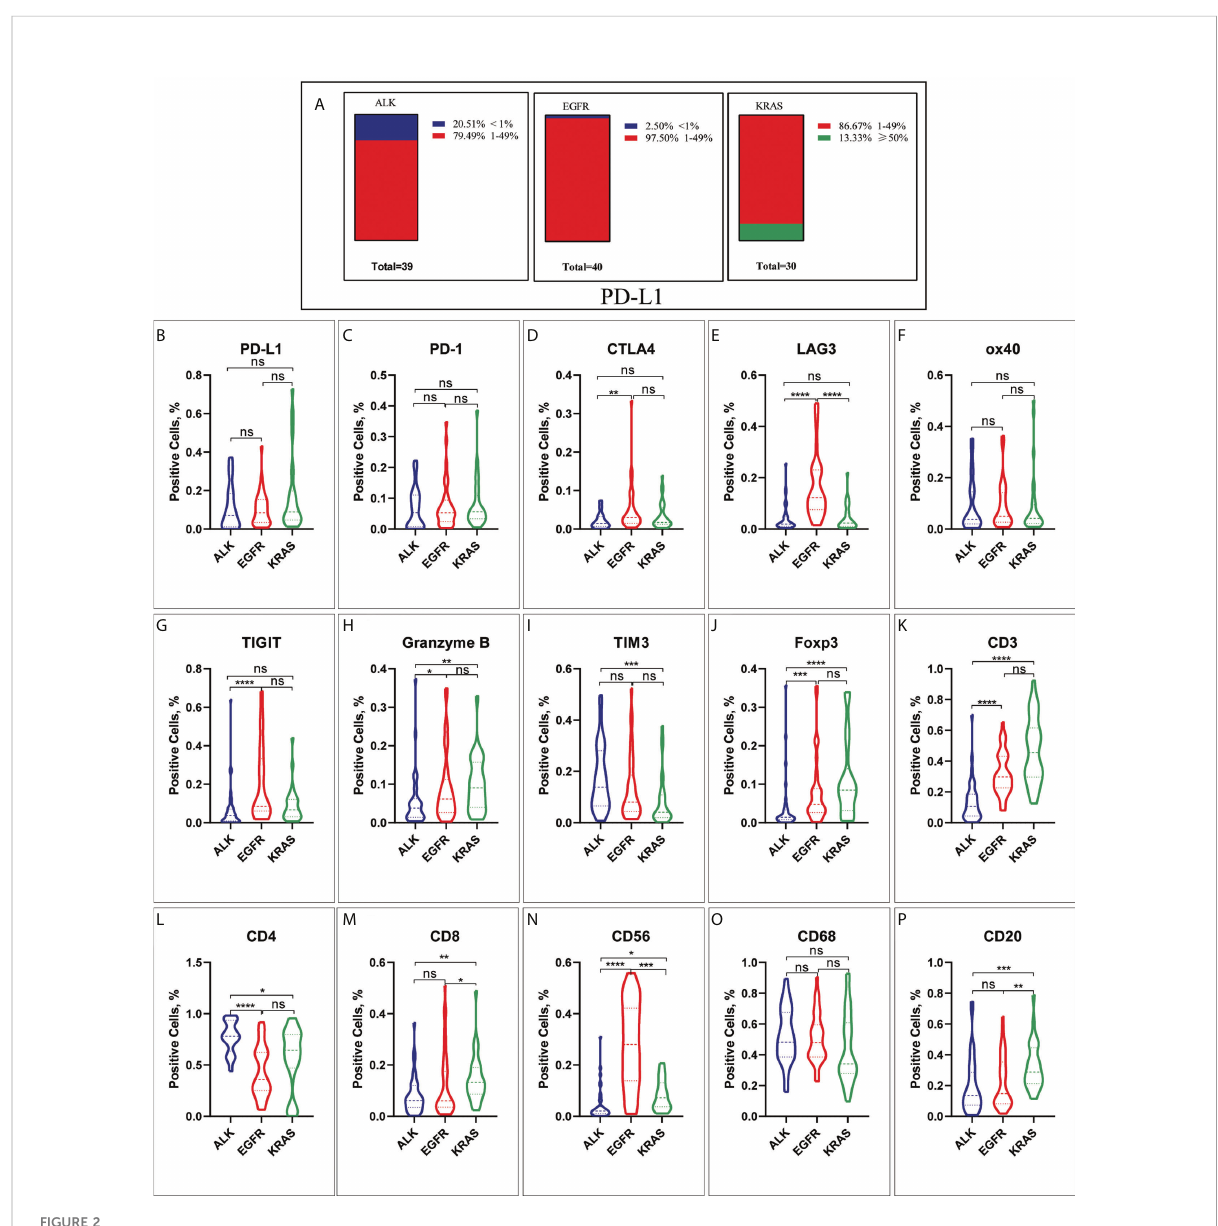
FIGURE 2 The characteristic of different immune checkpoints in ALK-positive, EGFR-positive and KRAS-positive NSCLC. (A) Frequency distribution of PD-L1 expression in ALK-rearranged, EGFR-positive and KRAS-positive NSCLC. (B) PD-L1, (C) PD-1, (D) CTLA4, (E) LAG3, (F) ox40, (G) TIGIT, (H) Granzyme B, (I) TIM3, (J) Foxp3, (K) CD3, (L) CD4, (M) CD8, (N) CD56, (O) CD68, (P) CD20. *p < 0.05, **p < 0.005, ***p < 0.0005, ****p < 0.0001. ns, No signi fi